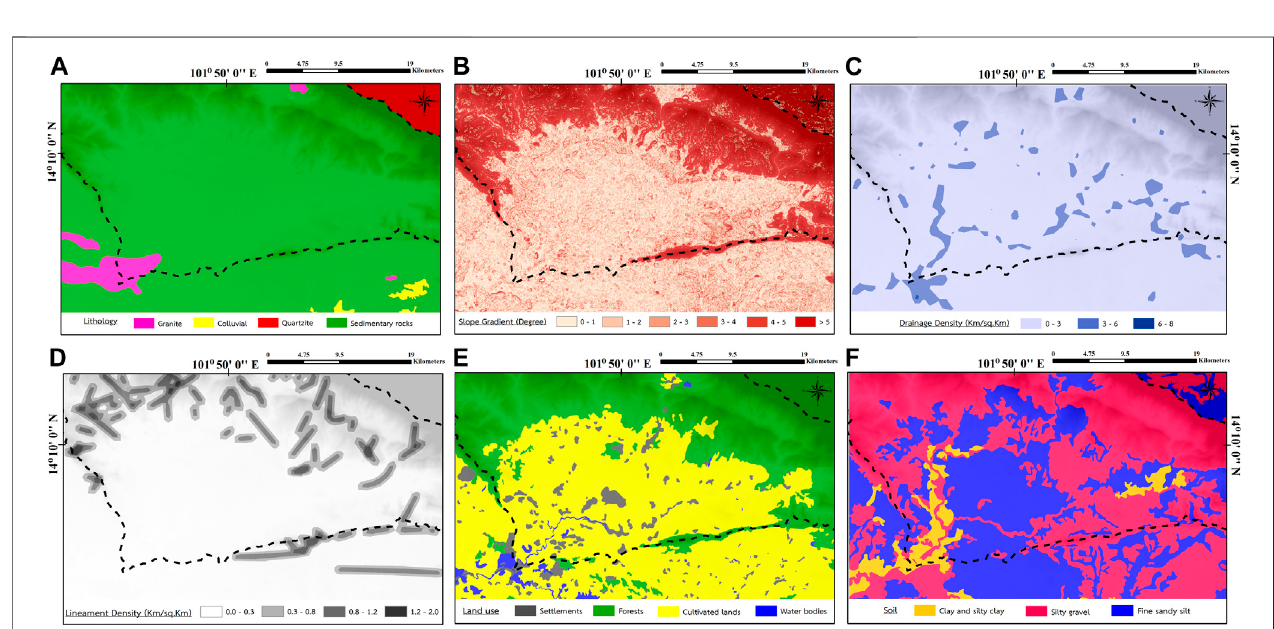
FIGURE 5 | Factors affecting the GRP of the LKM sub-basin, Prachin Buri Province, Thailand: (A) Lithology map, (B) Slope gradient map, (C) Drainage density map, (D) Lineaments ’ density map, (E) Land use map, and (F) Soils map.